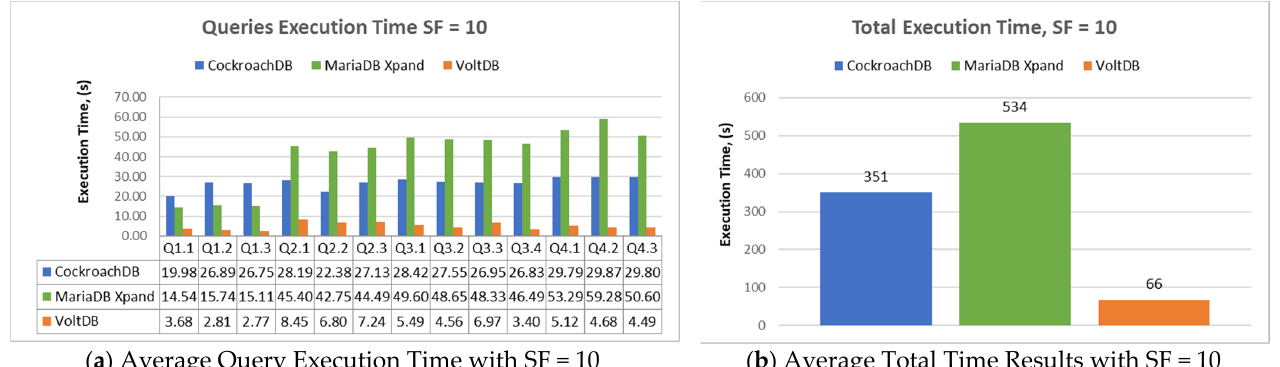
Figure 11. Results of execution time with SF = 10.